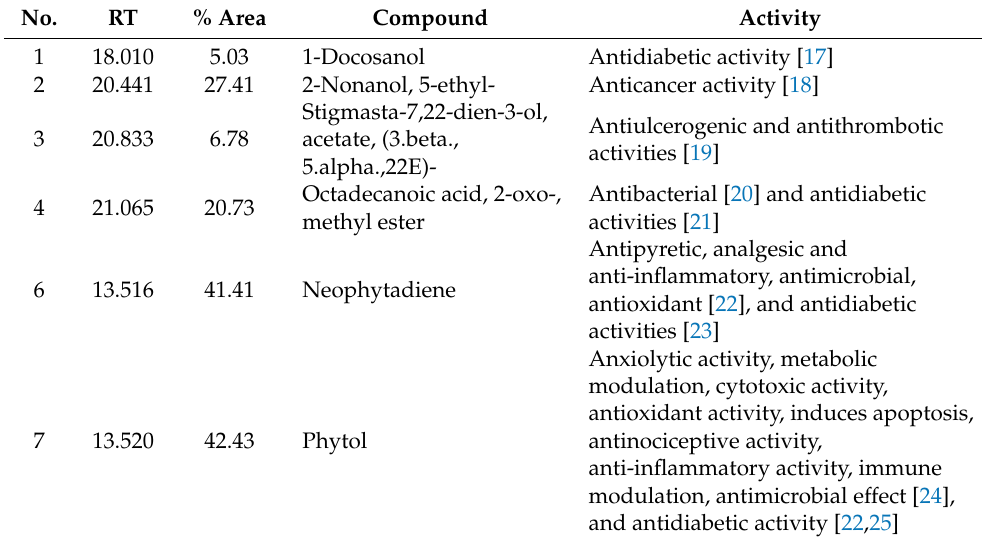
Table 3. Biological activity of compounds in methanol extract of H. tuna .